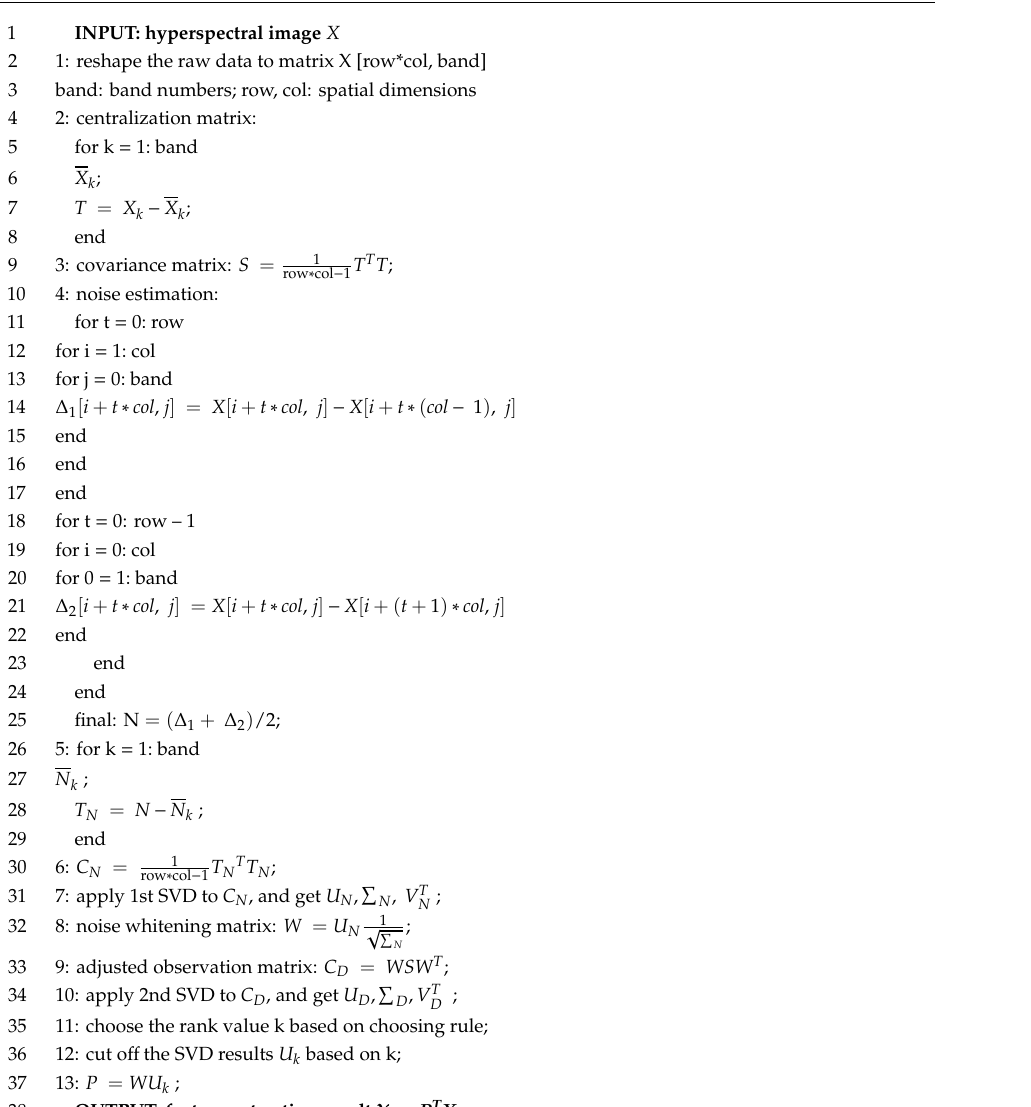
Algorithm 1: Improved noise adaptive principal component (INAPC)